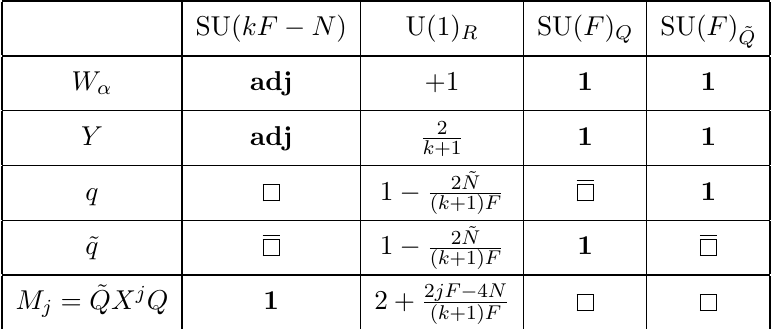
Table 4 . Quantum numbers of fields in the magnetic SU(